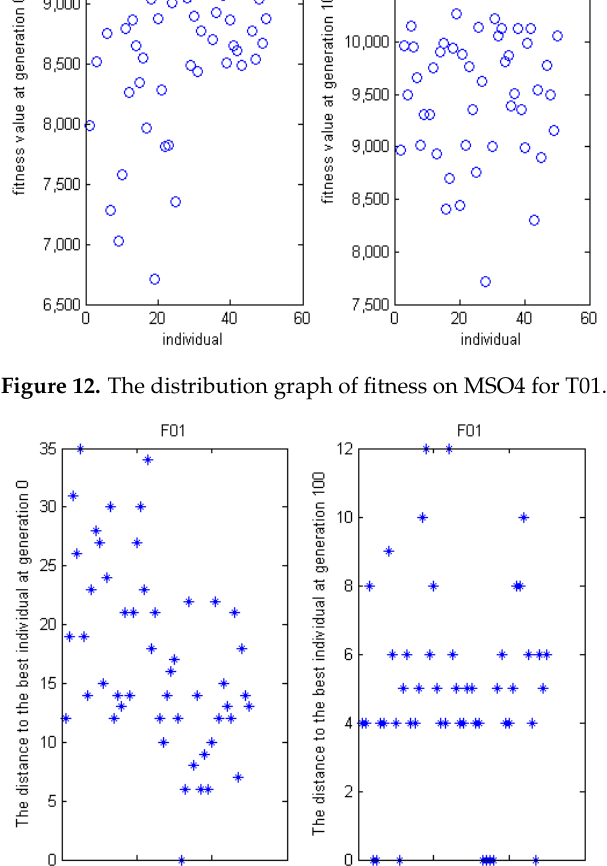
Figure 13. The distance to the best individual for F01.